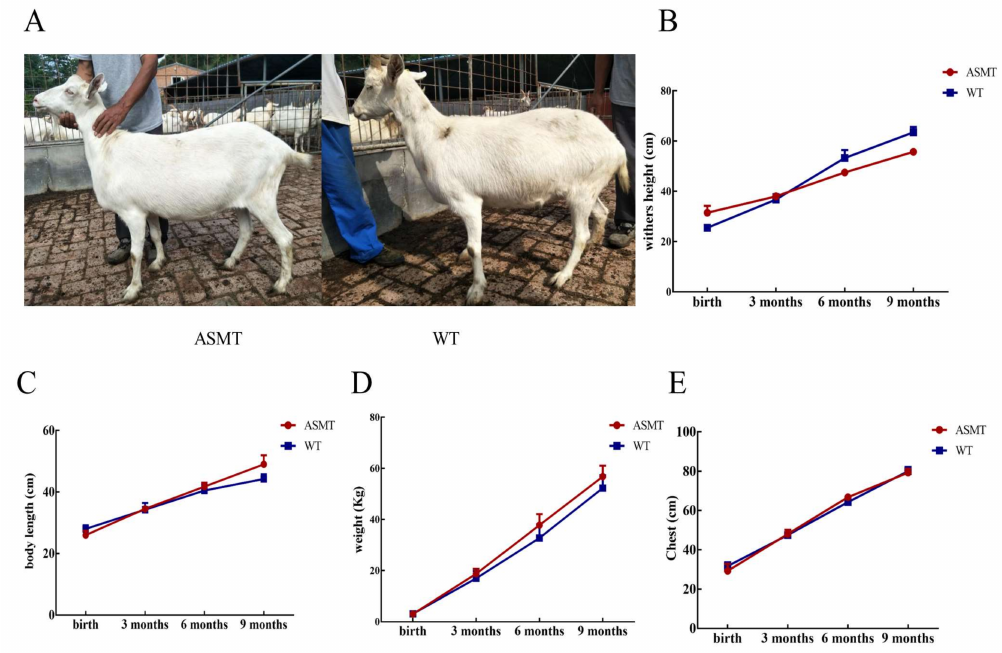
Figure 2. The general phenotype of ASMT -overexpressed goats compared to the WT goats. ( A ) Photos of ASMT -overexpressed and WT goats; ( B ) the body height; ( C ) the body length; ( D ) The body weight; ( E ) the breast size. Note: the transgenic goat ( n = 3), wild type ( n =